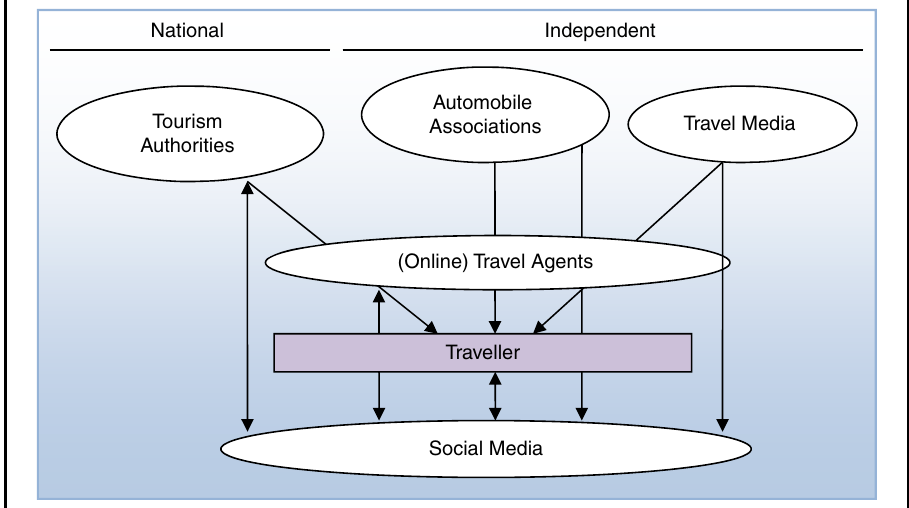
Figure 1 Organisations involved in hotel